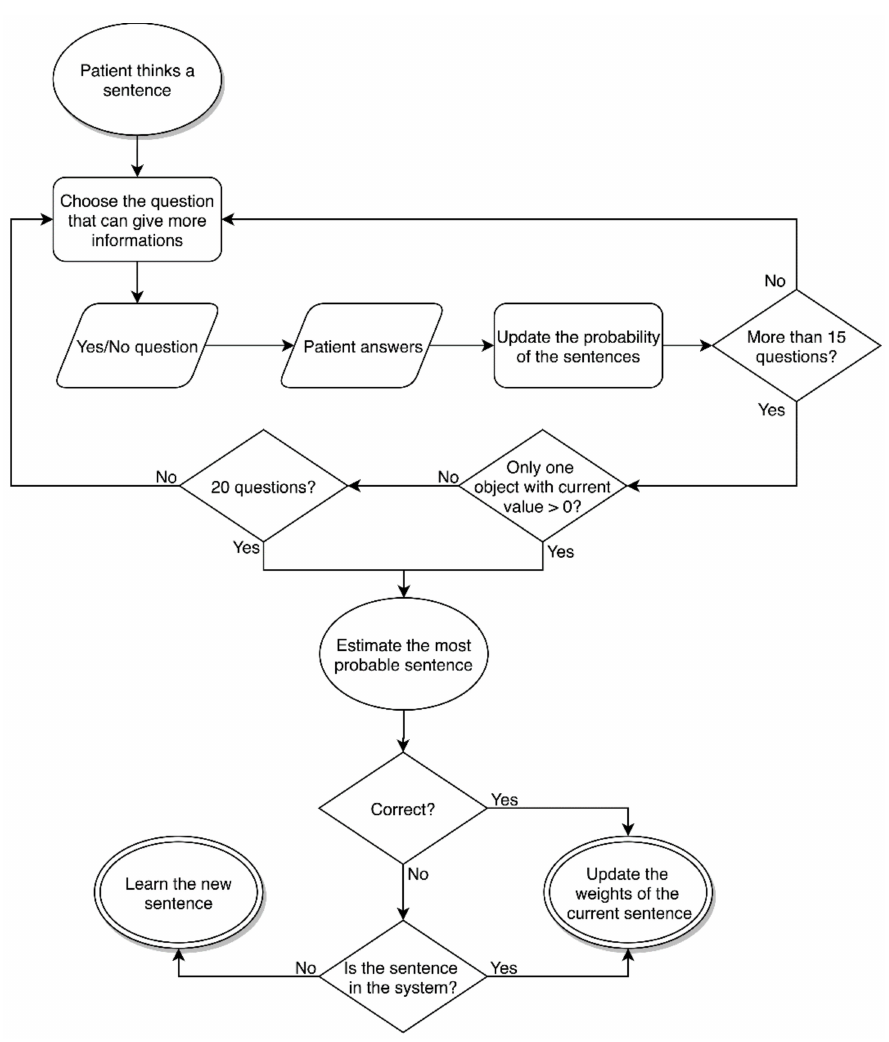
Figure 1. Flow chart of the proposed 20-questions-based communication